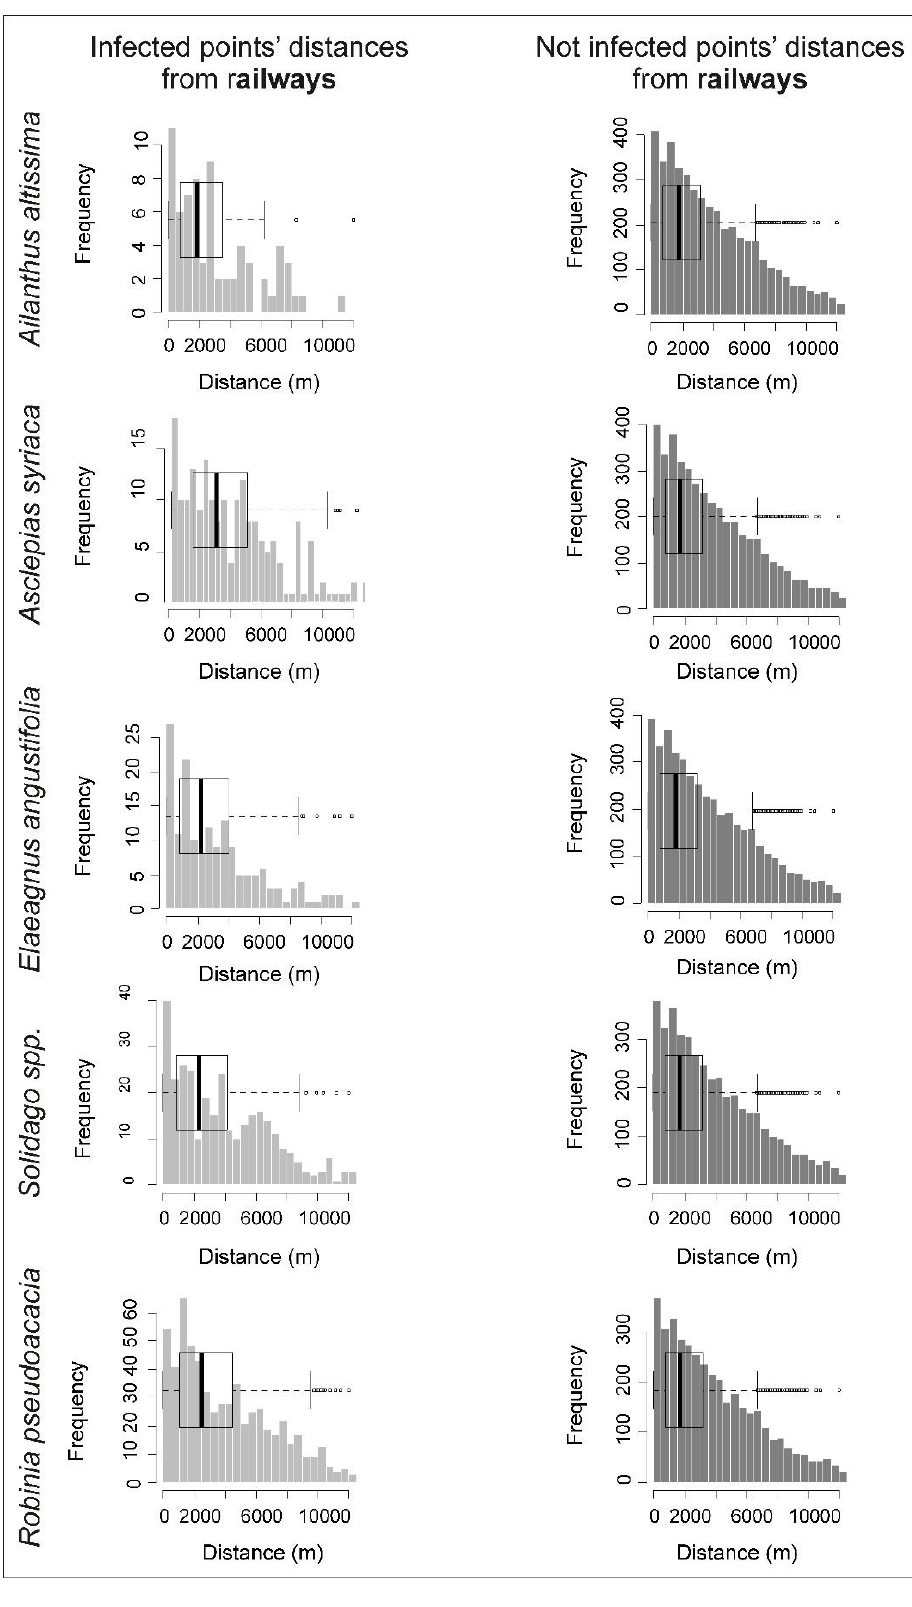
Figure A2. Histogram and boxplots of infected and not infected points’ distances from railways .